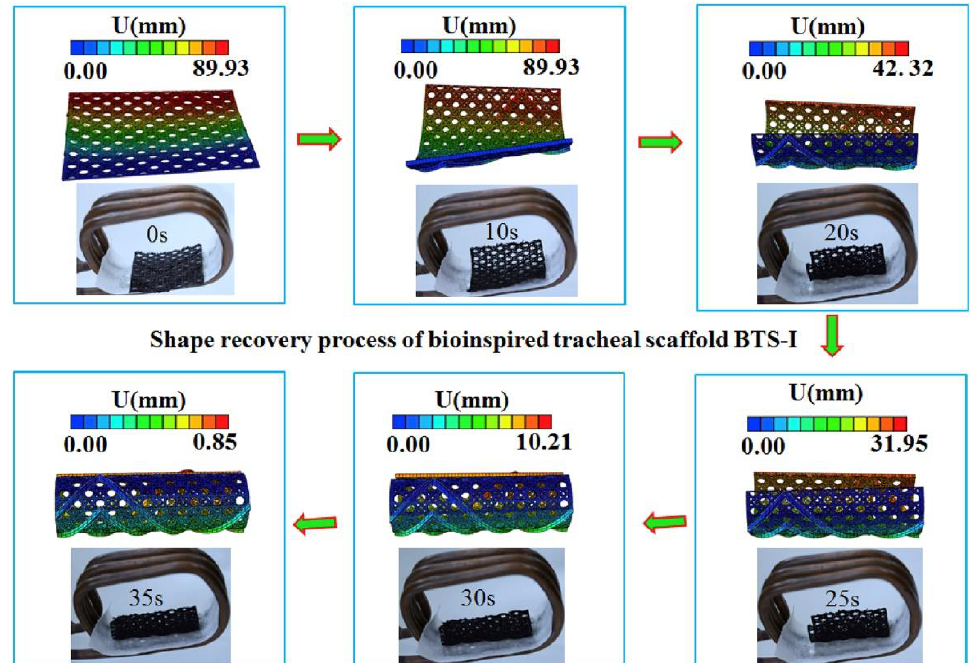
Figure 9. Shape recovery of a bioinspired tracheal scaffold. Reprinted from [67], copyright (2019), with permission from Elsevier.